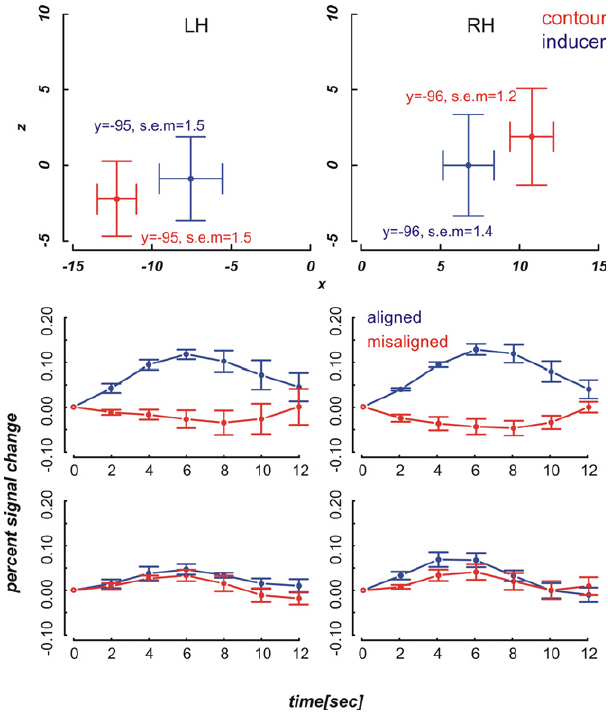
Figure 5. Mean ROI locations and peristimulus plots at ROIs in the near condition. The design of the fi gures is analogous to that of Figure